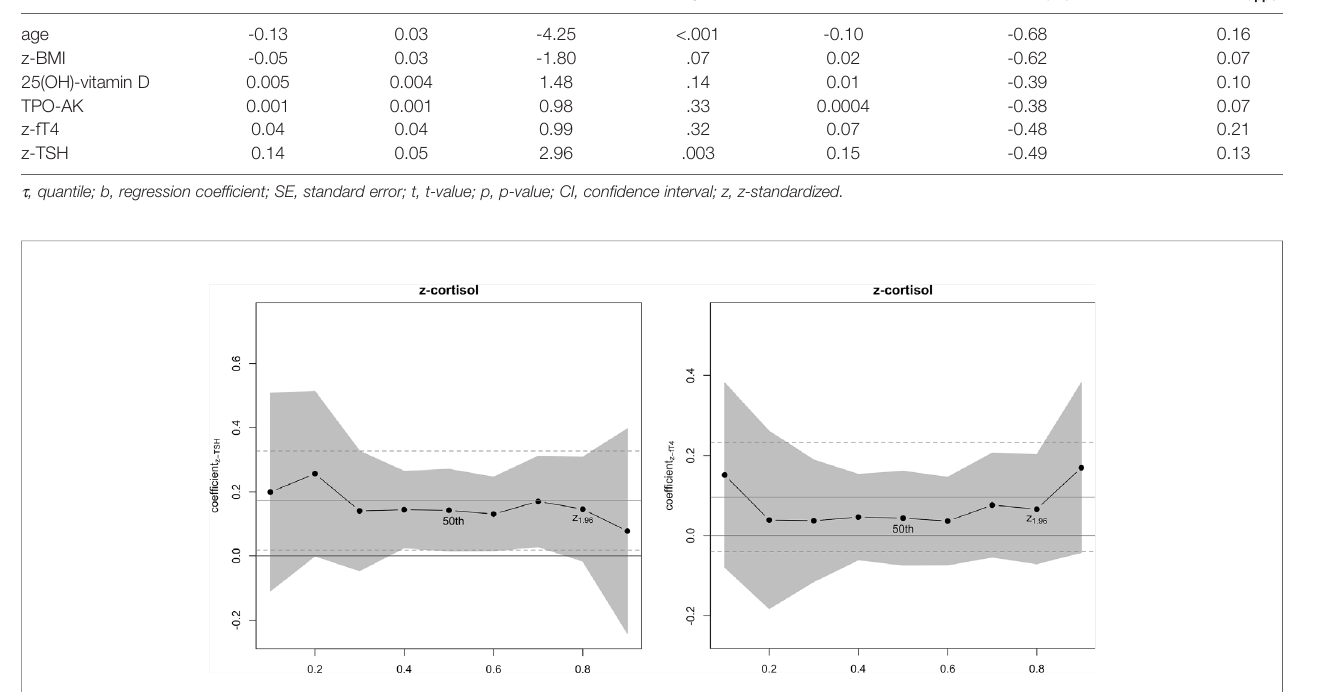
FIGURE 2 | Quantile regression coef fi cients (y-axis) for different quantiles ( t , x-axis) regarding the relationship between z-standardized TSH, fT4, and cortisol. A 99.2% con fi dence interval (CI), resulting from adjustments for multiple comparisons, for the quantile regression coef fi cients at the respective t -levels is displayed in dark grey (Note, only the CI based on the standard error derived from the Huber sandwich estimator is displayed). Horizontal solid lines in light gray correspond to the multiple regression coef fi cient on the y-axis of the respective fi gure, and horizontal dashed lines in light grey represent the 99.2%-CI regarding these coef fi cients. The 50 th percentile and the percentile at which z equals 1.96 are highlighted.